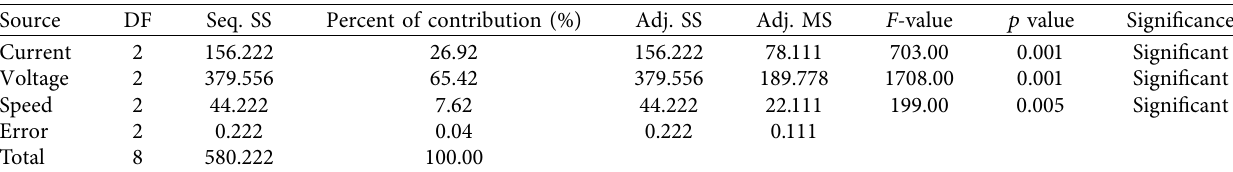
Table 12: General linear model of hardness of HAZ ANOVA table.